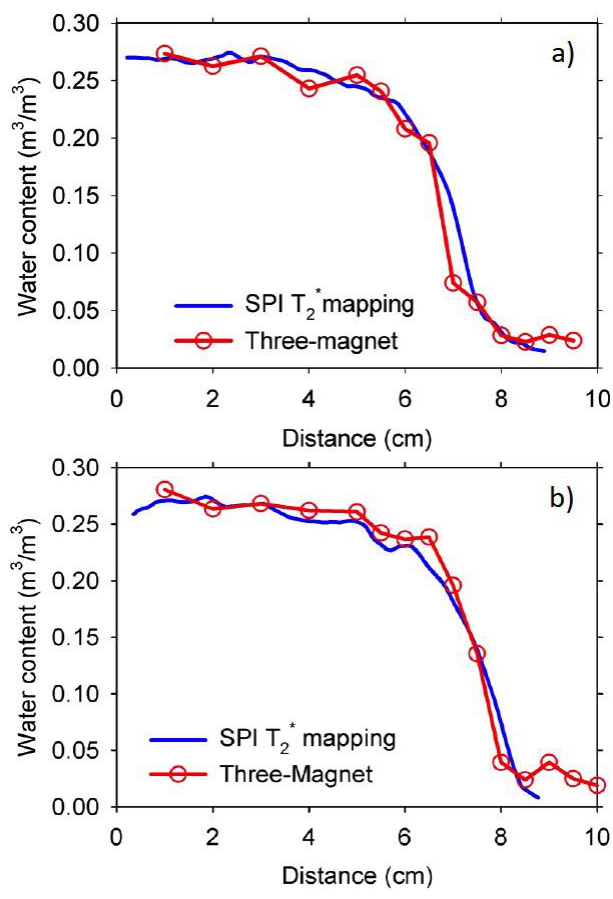
Figure 5. Water content distribution from SPI T 2* mapping and CPMG signal intensity for the 0.60 w/c ratio, 100 mm long duplicate mortar samples ( a , b ) at four days of water absorption. Profiles with the T 2* mapping were obtained by moving the sample in two steps due to the sample length restriction of the MRI instrument. The T 2* was about 171 μs.